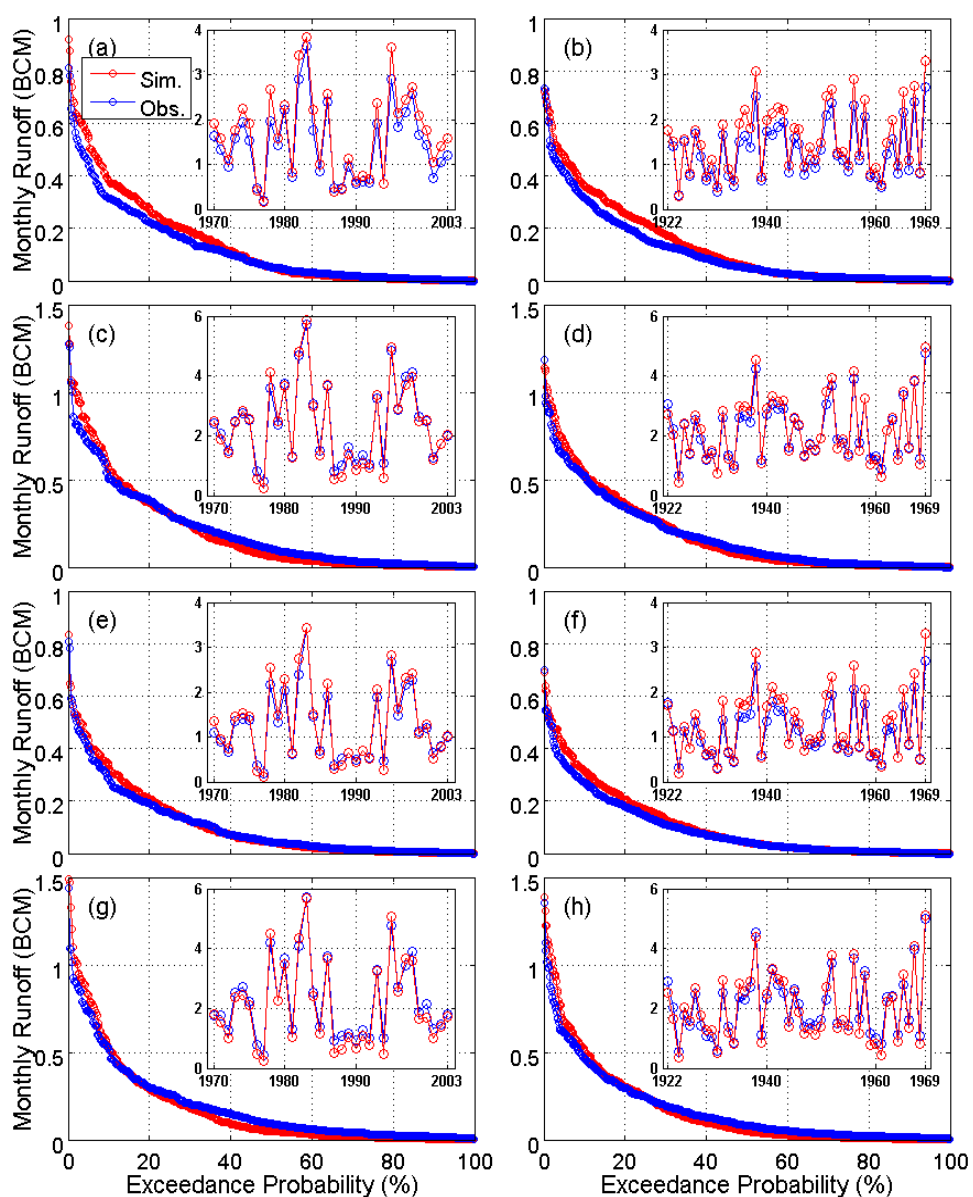
Figure A2. Exceedance probability (%) of simulated and observed monthly runoff (billion cubic meter (BCM)) during the calibration period (first column) and validation period (second column) for watersheds: Stanislaus River (SNS; a, b ), Tuolumne River (TLG; c, d ), Merced River (MRC; e, f ), and San Joaquin River (SJF; g, h ). The insert plots show corresponding simulated and observed annual runoff (vertical axis; in BCM) during the calibration or validation period (horizontal axis; in water year).